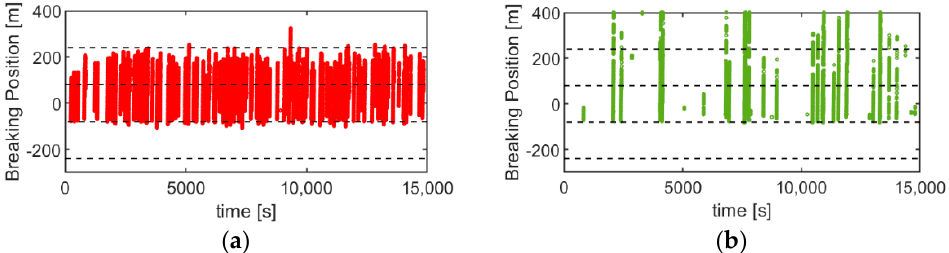
Figure 13. Breaking events for wave case H6T12 over the shoal (position vertically) for the full-time trace of the simulation (15,000 s): ( a ) for the 1D long-crested waves and ( b ) for short-crested waves crossing a 200-m-wide interval perpendicular to the waves.